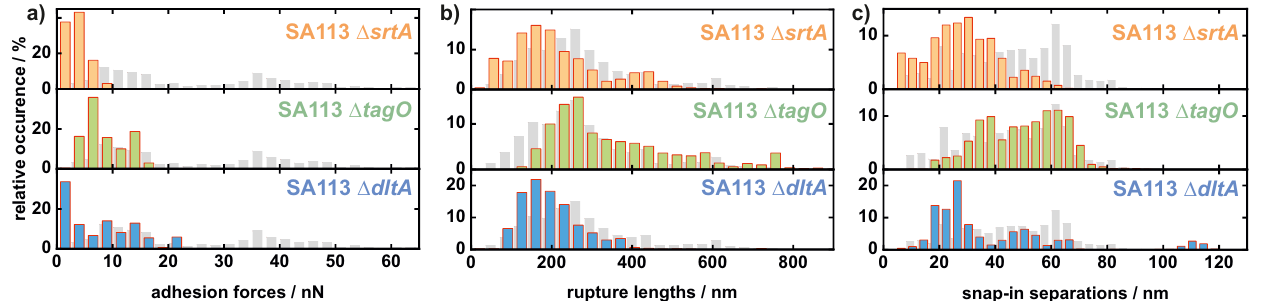
Figure 3. Histograms of all measured values of adhesion force ( a ), rupture length ( b ), and snap-in separation ( c ) of 18 single SA113 ∆ srtA , 16 single SA113 ∆ tagO , and 17 single SA113 ∆ dltA cells on hydrophobic surfaces. Additionally, the corresponding values of the SA113WT population are shown in gray